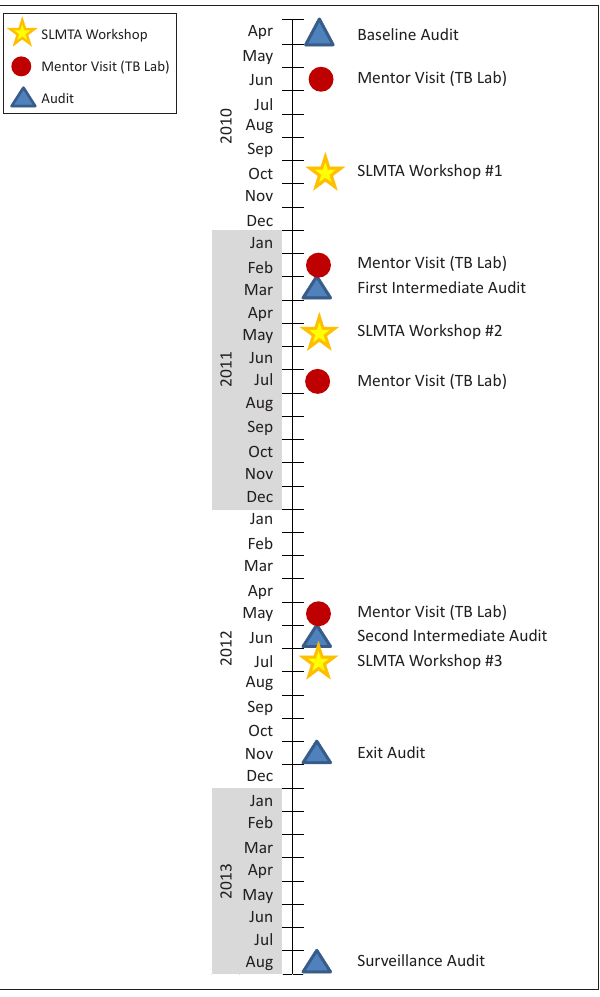
FIGURE 1: SLMTA implementation timeline in Nigerian reference